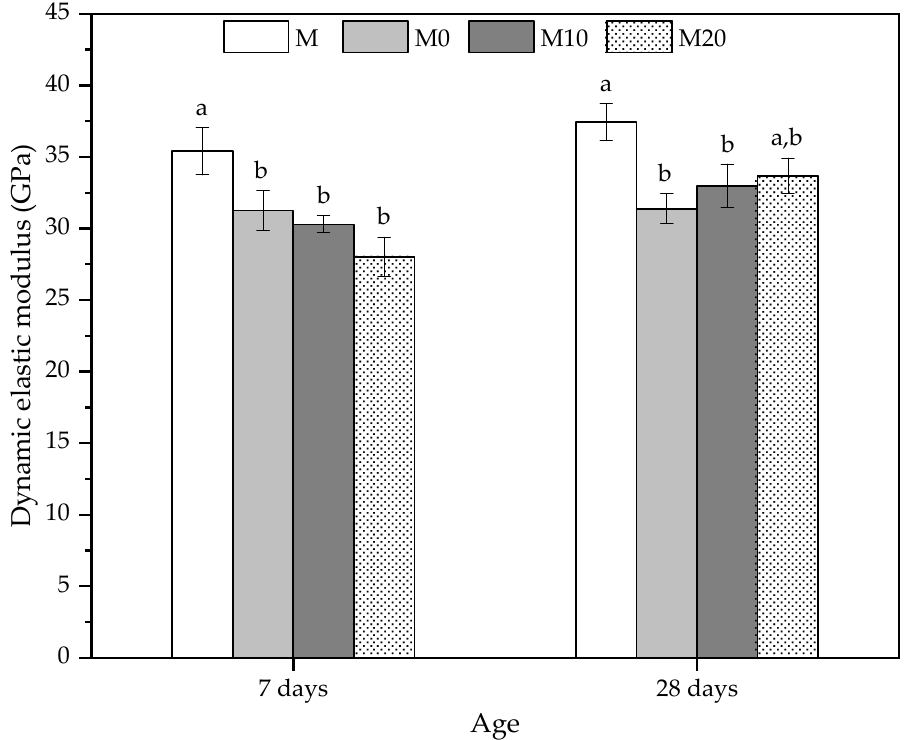
Figure 6. Dynamic elastic modulus at 7 and 28 days obtained by ultrasonic velocity to mortars produced with 0, 10, and 20% Cloisite Na + nanoclay hydrogels. Average with their respective standard deviation values, followed by equal letters do not differ statistically from each other following the Tukey test with a 95% confidence level.